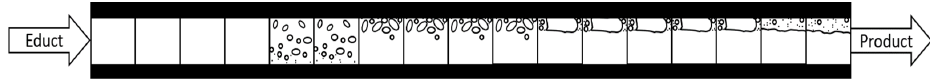
Figure 4. Sketch of the discrete calculation of the tubular reactor with a finite-element method.